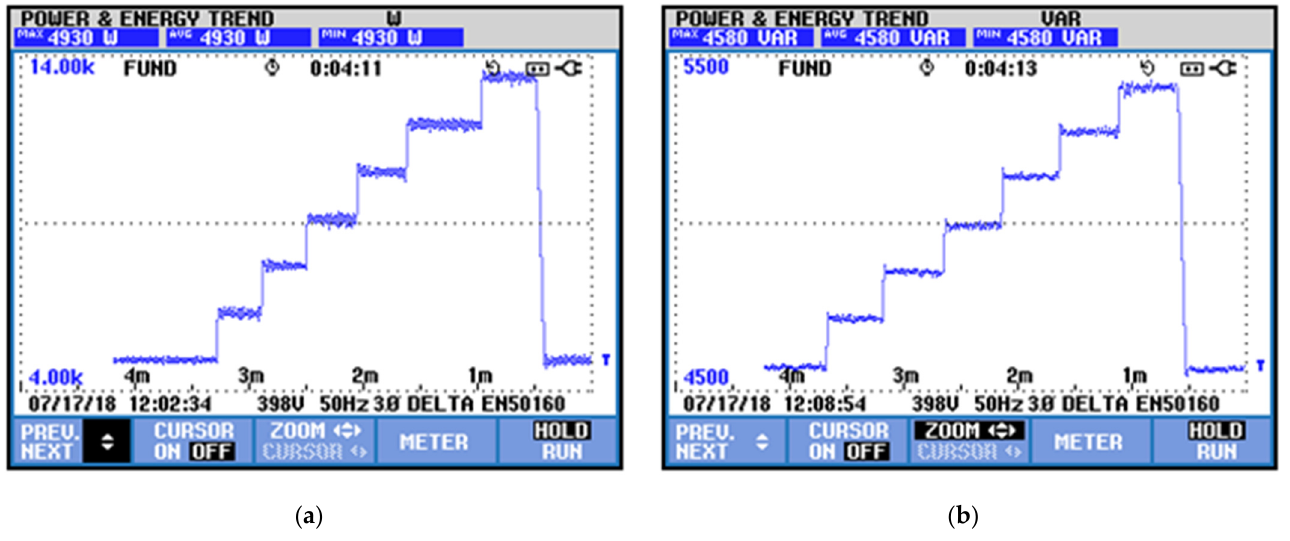
Figure 16. ( a ) Active power variation; ( b ) Reactive power response result.